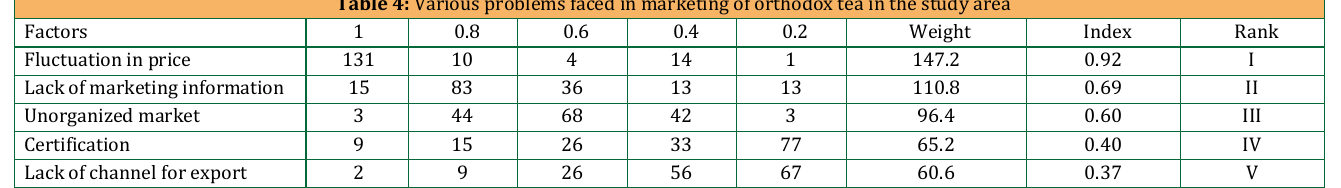
Table 4: Various problems faced in marketing of orthodox tea in the study